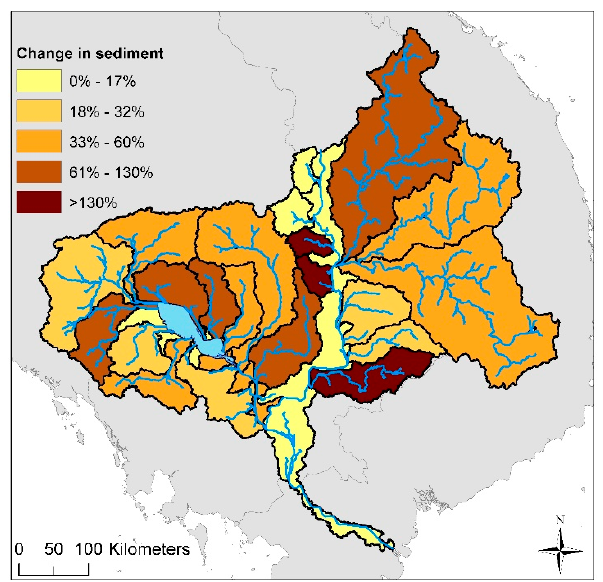
Figure 8. Results by watershed for percent change in river discharge and sediment yield as a result of land cover changes between 2001 and 2013.